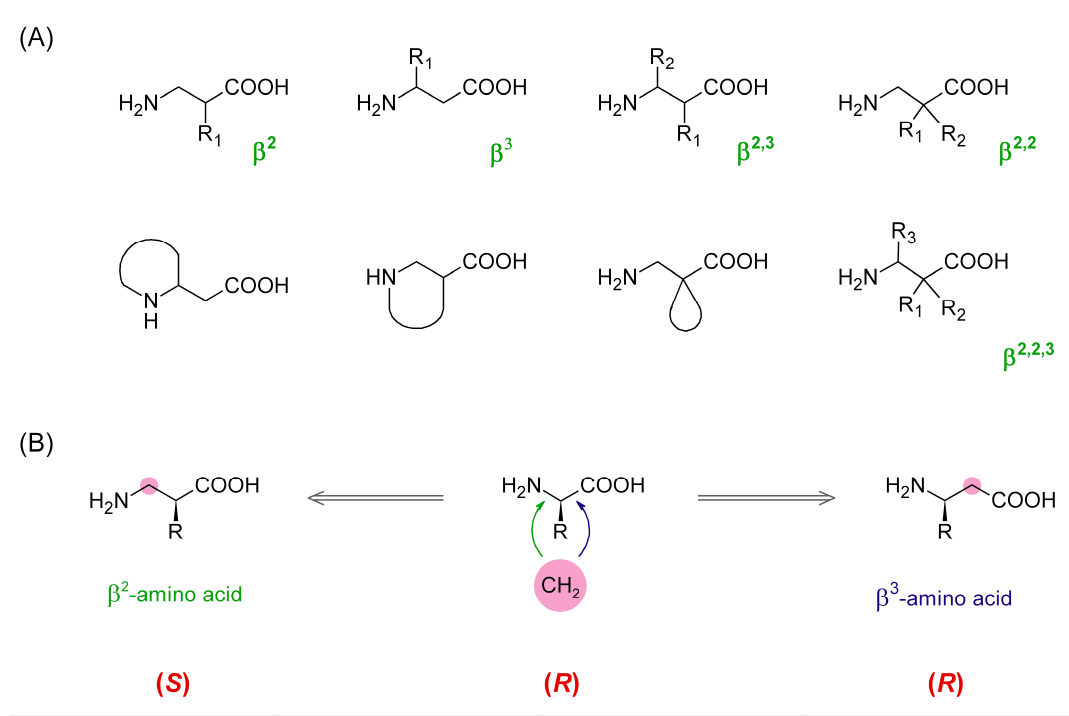
Figure 1. ( A ) Examples of diverse possible types of β -amino acids. ( B ) Comparison of absolute configuration of α -, β 2 -, and β 3 -amino acids.